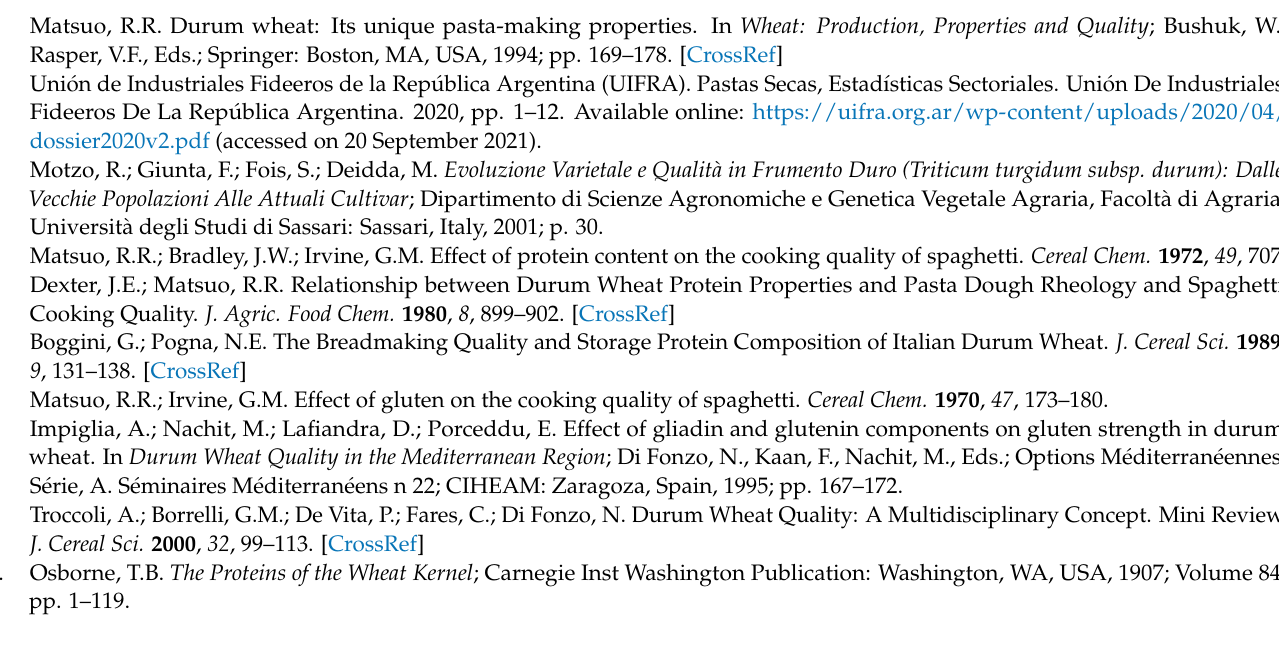
study. Table S3: Precipitation, mean temperature and adopted management in the seven field trials. Table S4: Summary of genotypes/haplotypes and trials considered with additional quality parameters. Table S5: Percentage of variance explained by each locus, model and haplotypes for GPC and SDS sedimentation test. Table S6: Frequency and distribution of haplotypes according to the origin of